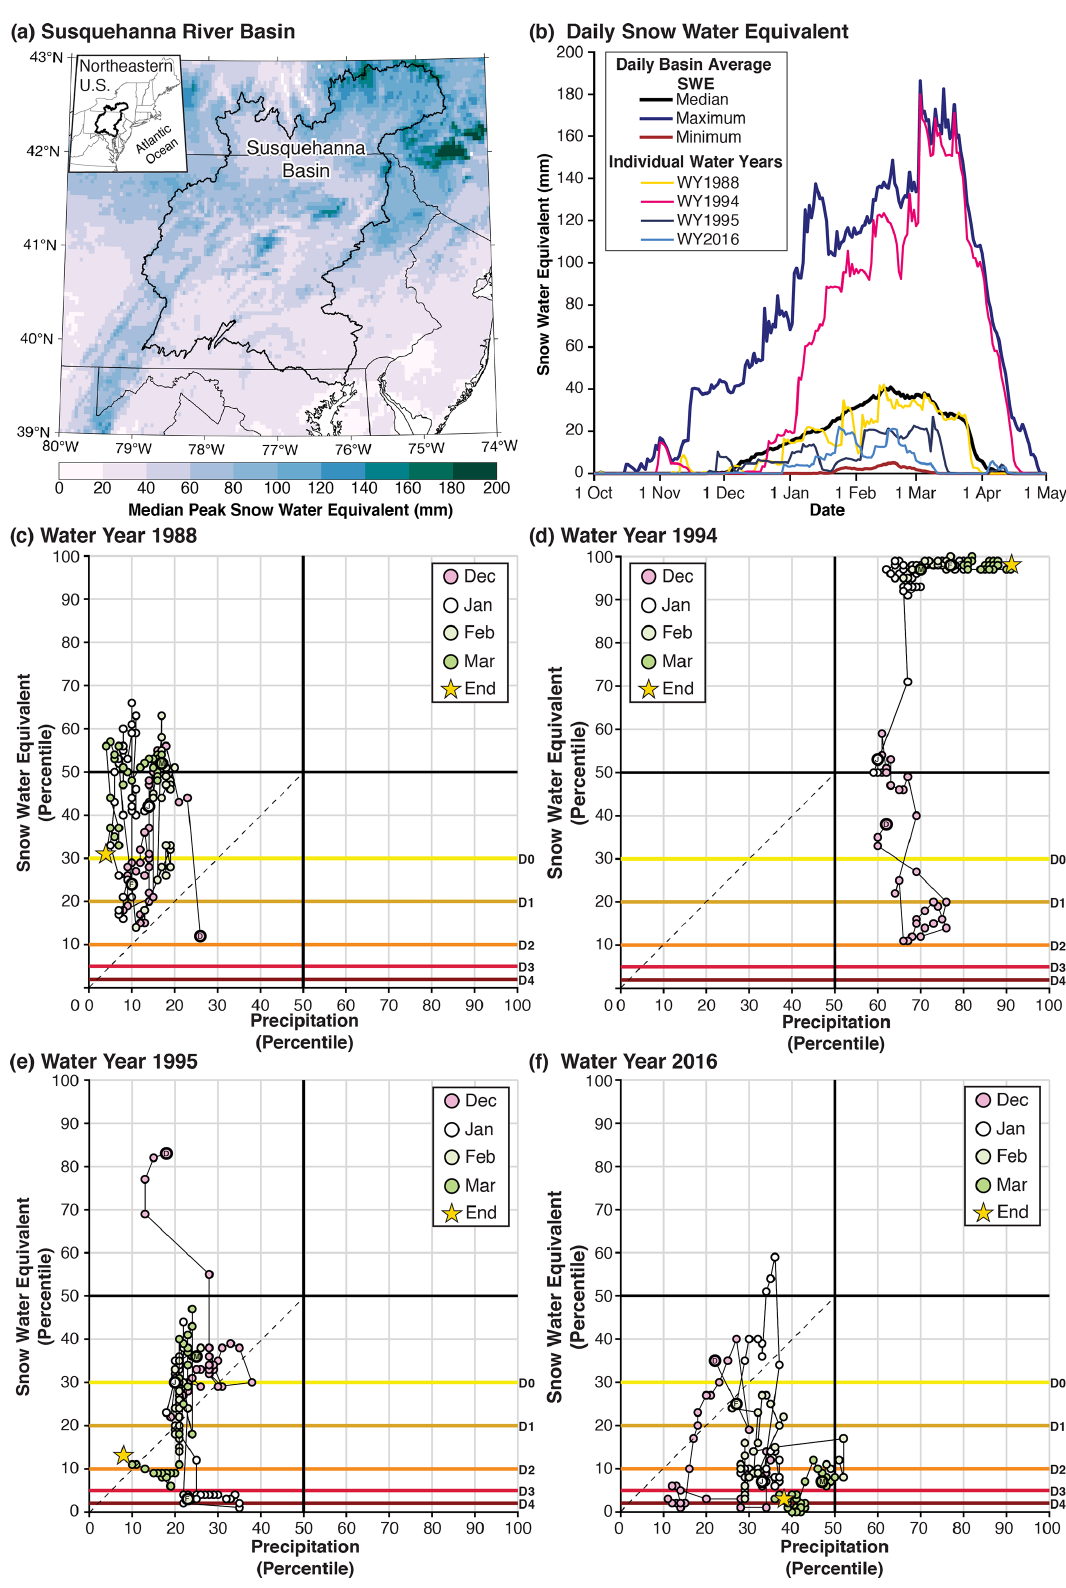
Figure 7. (a) Peak snow water equivalent (SWE) in the Susquehanna River basin (b) . Daily SWE climatology and time series of 4 water years. Phase diagrams for (c) water year (WY) 1988, (d) WY 1994, (e) WY 1995, and (f) WY 2016. Nat. Hazards Earth Syst. Sci., 22, 869–890,